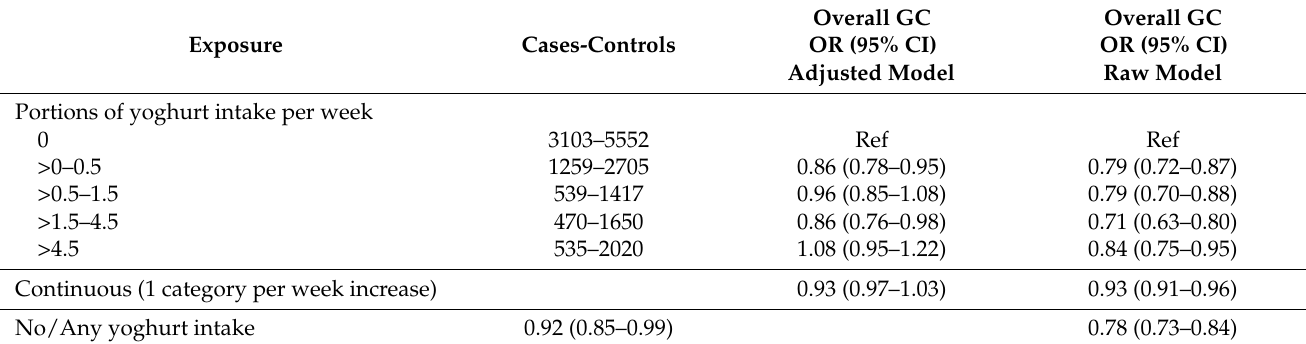
Table 2. Odds ratios (OR) and 95% confidence intervals (CI) of the association between portions of yoghurt intake per week and gastric cancer (GC), based on the study [21–29,31–33].